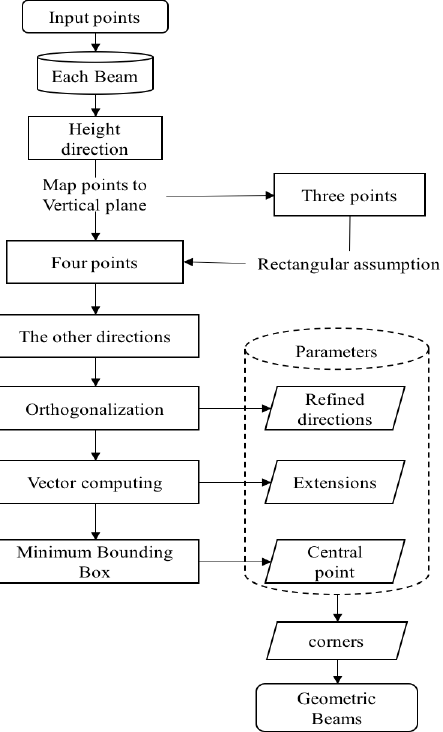
Figure 9. Beam reconstruction